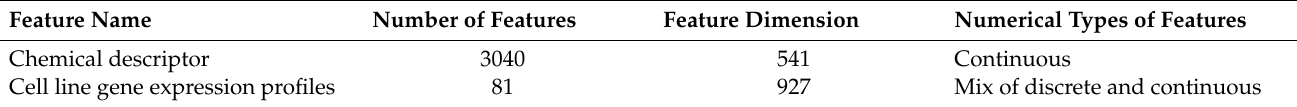
Table 8. The drug combinations with high predictive synergy scores in terms of all synergy